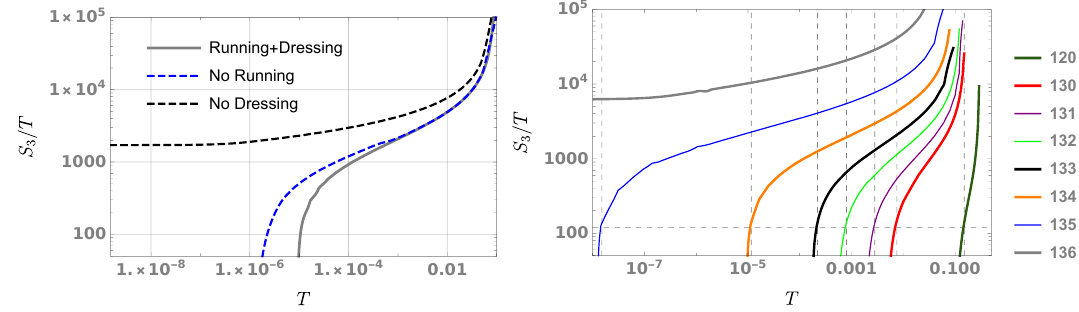
Figure 2 . On the left, illustration of the e(cid:11)ects of the running and of the thermal masses for N f = 134. We can see that the e(cid:11)ect of the running, as it increases the couplings, is to shorten the supercooling, but it remains slight though. On the other hand, the e(cid:11)ect of the thermal masses is quite dramatic and determines the moment of the transition. On the right, we represent the S 3 ( T ) as a function of the temperature for N f = 120 ; 130{136. The horizontal dotted line represent the nucleation condition S 3 ( T ) T